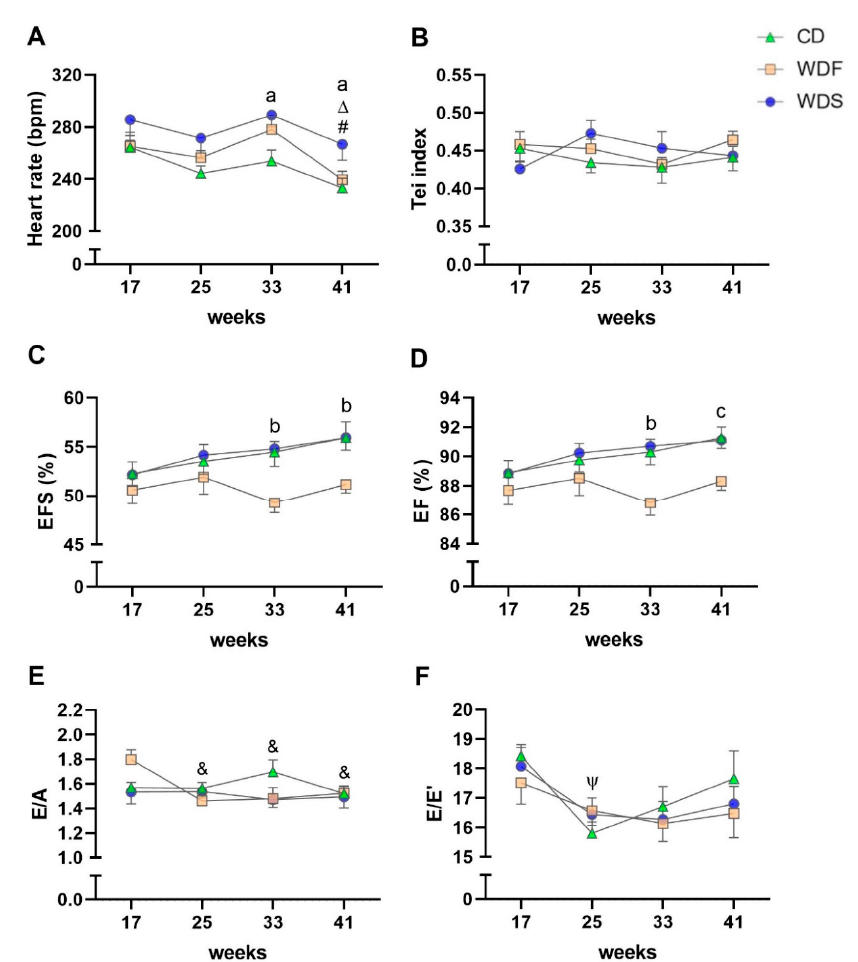
Figure 7. Serial echocardiographic functional assessment. The analysis was performed at 17th, 25th, 33rd, and 41st week of dietary intervention with Control diet (CD), Western diet fat (WDF), and Western diet sugar (WDS). ( A ) Heart rate. ( B ) Tei index. ( C ) Endocardial fractional shortening (EFS). ( D ) Ejection fraction (EF). ( E ) early (E) and late (A) diastolic mitral inflow velocities ratio. ( F ) E and tissue Doppler imaging (TDI) of early mitral annulus diastolic velocity (E’) ratio. Data are presented as mean ± s.e.m. Two-way repeated-measures ANOVA and Bonferroni post hoc test. Symbols indicate differences between the moments fixed the group. Letters indicate differences between the groups fixed the moment. # p < 0.001 vs. 17 weeks for C and WDF; Δ p < 0.05 vs. 33 weeks for WDF; & vs. 17 weeks for WDF; Ψ vs. 17 weeks for C; a C vs. WDS, b C and WDS vs. WDF; and c C vs. WDF (n = 10 per group).